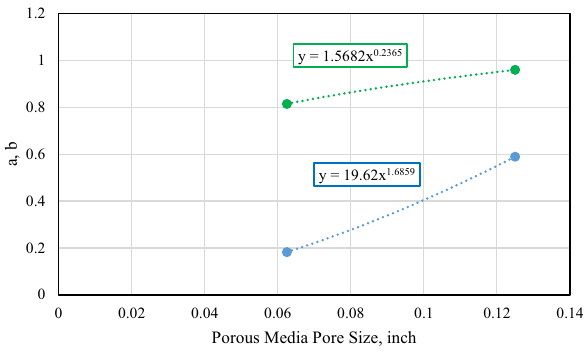
Fig. 5 “ a ” and “ b ” parameters for different pore